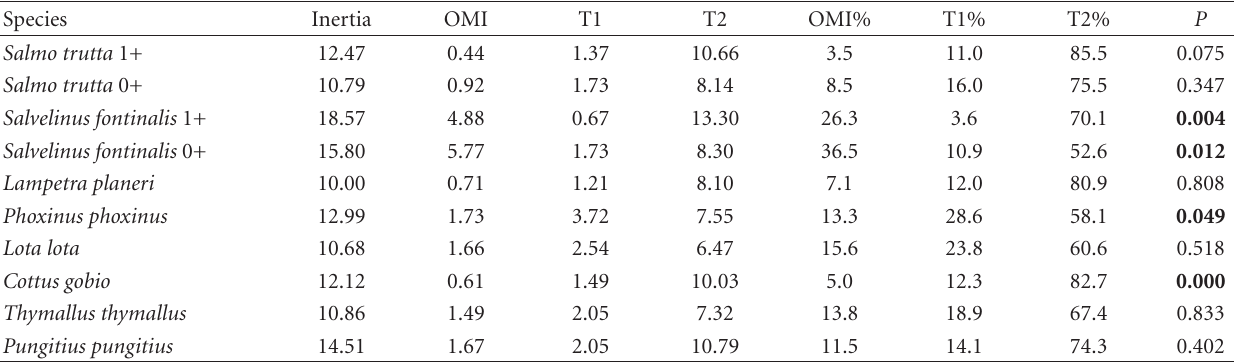
Table 3: Niche characteristics of the fish species in the 1994 survey. Brown trout ( Salmo trutta ) and brook trout ( Salvelinus fontinalis ) were divided into young-of-the-year (0+) and older fish (1+). Inertia: variability of species niche; OMI: outlying mean index or niche position; T1: species tolerance or niche breadth; and T2: residual tolerance. Percentages are from inertia for each species. Significances are from permutation test of the null hypothesis that a species’ OMI value is not di ff erent from that expected by chance (1000 permutations). Species